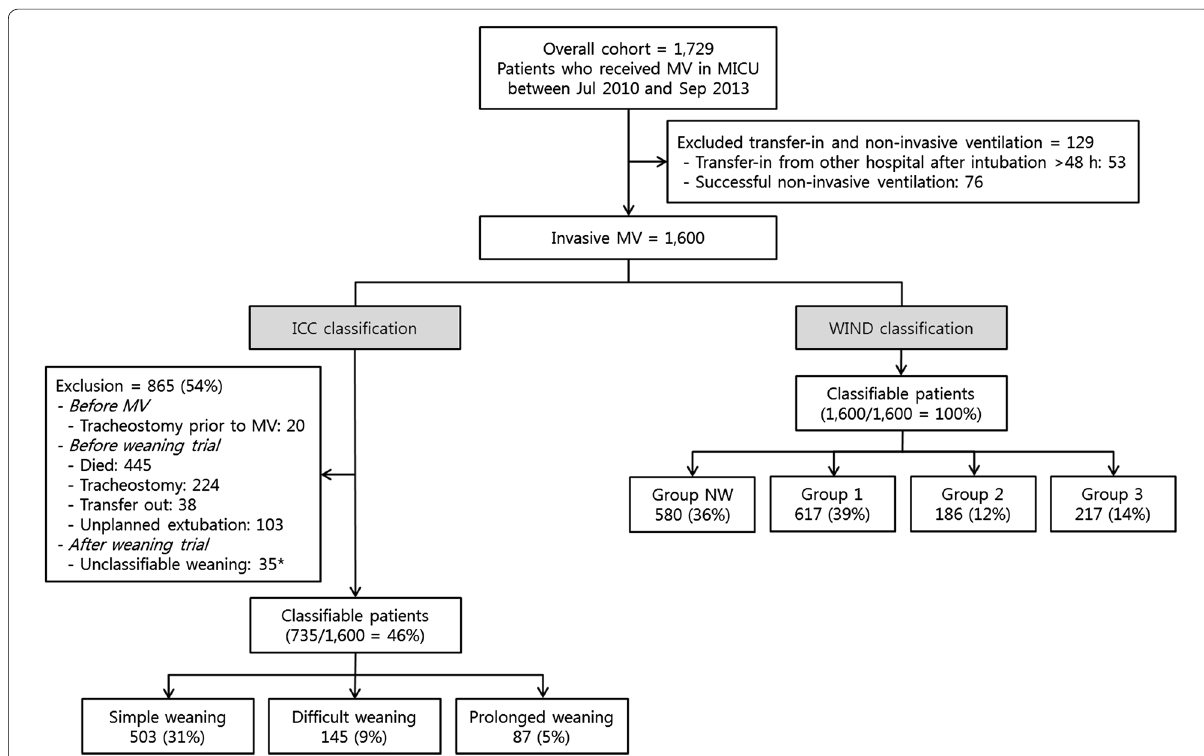
Fig. 1 Flowchart of WIND and ICC classifications. *Patients who died or were transferred to other hospitals after failure of first SBT and before third SBT or 7 days. MV mechanical ventilation, MICU medical intensive care unit, ICC International Consensus Conference, WIND Weaning according to a New Definition, NW no